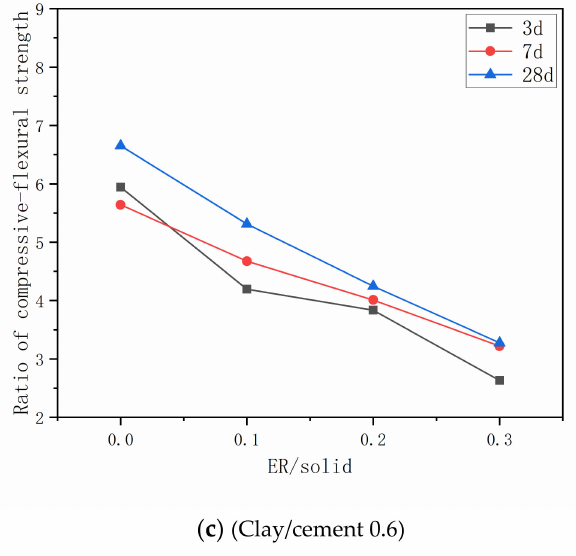
Figure 7. Development of the ratio of compressive-flexural strength. ( a ) Clay/cement 1.4; ( b ) Clay/ cement 1; ( c ) Clay/cement 0.6.